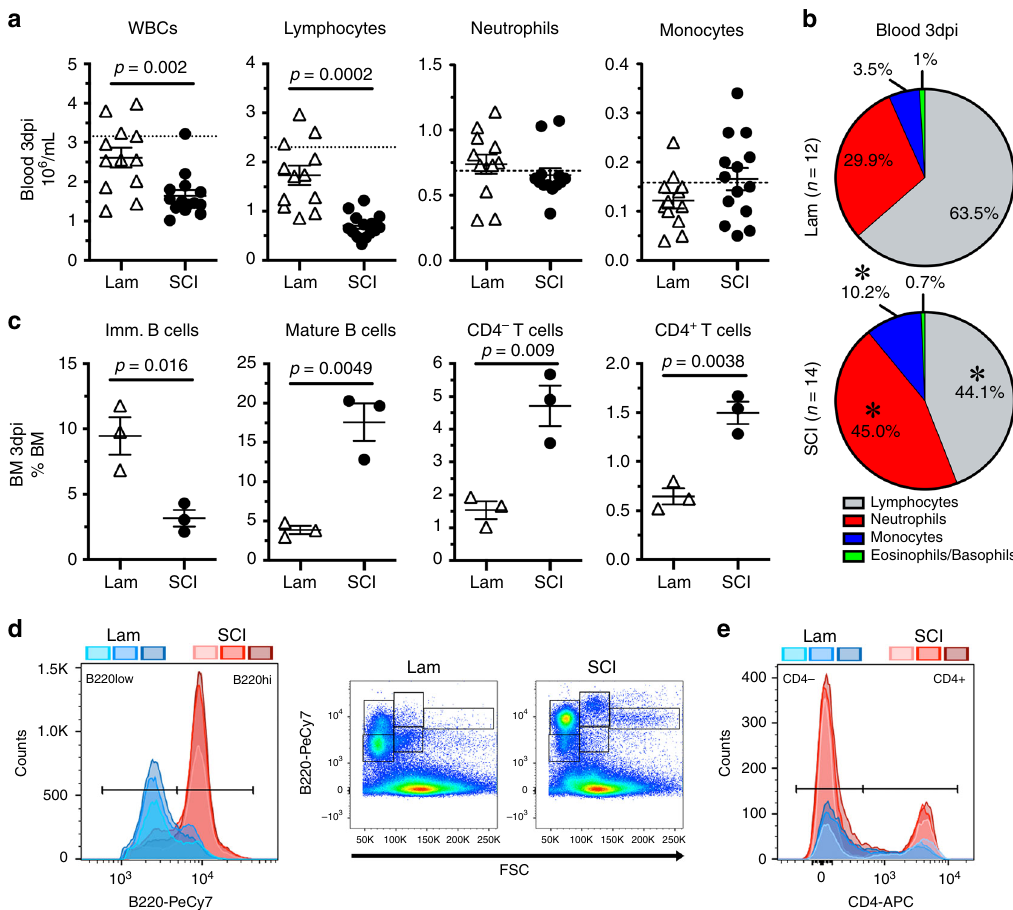
Fig. 5 T3 transection SCI causes acute lymphopenia in blood with concurrent sequestration of lymphocytes in bone marrow. a Total numbers of white blood cells (WBCs), lymphocytes, neutrophils, and monocytes per mL of whole blood at 3 dpi. b Lymphocytes (gray), neutrophils (red), monocytes (blue), and eosinophils/basophils (yellow) as a proportion of total WBCs. c Proportion of immature (i.e. developing) B cells (B220 low ), mature B cells (B220 hi ), and mature CD3 + T cells (CD4 − and CD4 + subsets) in bone marrow. d Flow cytometry gating of bone marrow B220 + B cells demonstrating reduced numbers of immature (B220 low ) and increase numbers of mature (B220 hi ) B cells with SCI. Examples of B220 and forward scatter (size) characteristics of B cells in bone marrow after sham injury and SCI. e Flow cytometry gating of bone marrow CD3 + /CD4 − and CD3 + /CD4 + mature T cell subsets demonstrating increased numbers after SCI. All data are mean ± SEM, * p < 0.05, two-sample t -test; n = 12 and 14/group in a , b ; n = 3/group in c – e . Shades of blue/red (Lam/SCI) represent individual sample plots in d and e . Dotted lines represent average data from naïve mice. dpi days post-injury,